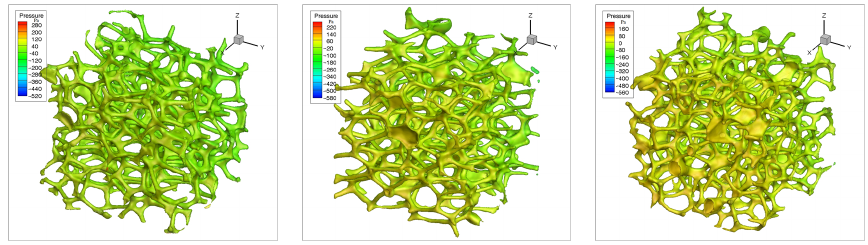
Figure 4. Overall relative pressure distribution.